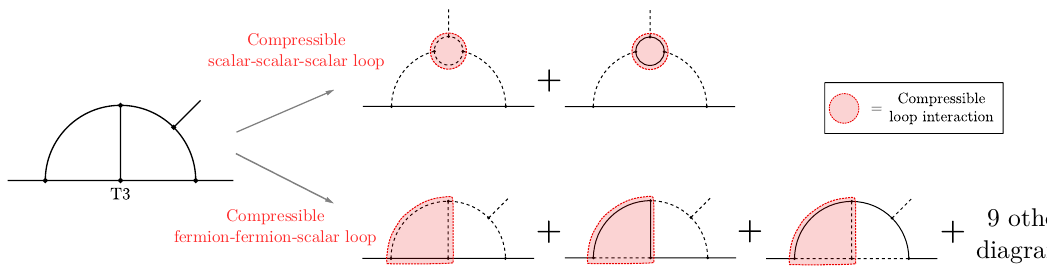
Figure 2 . Set of renormalizable diagrams generated from topology T 3. We found that the topology is not genuine at the diagram level as all the diagrams contain a reducible 3-point loop vertex, coloured in red for each case. The same happens with T 4 and T 5. Among the diagrams two di(cid:11)erentiated sets are given regarding the type of reducible loop vertex. This will be important at the model-diagram level, in order to promote this a priori non-genuine diagrams to genuine in sections 2.3 and 2.4.